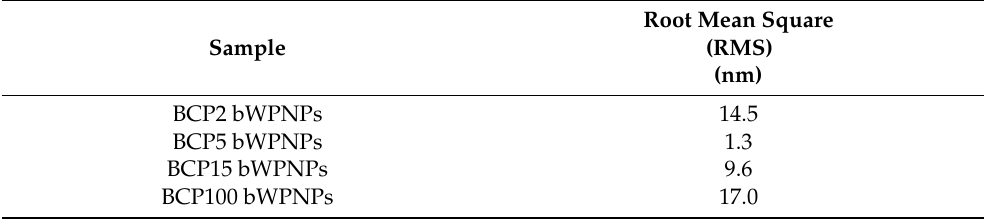
Table 3. Root mean square (RMS) values corresponding to the BCP2, BCP5, BCP15, and BCP100 bWPNPs (Figure